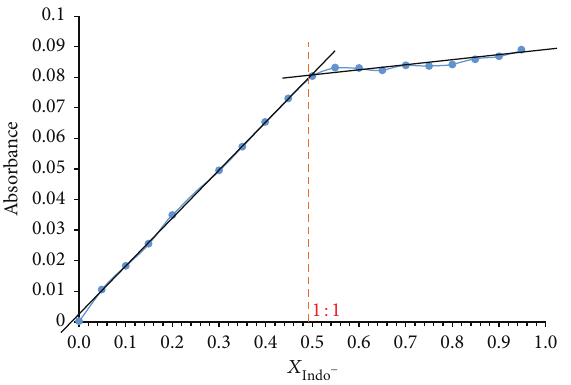
Figure 10: 𝐴 335 = 𝑓(𝑋 Indo − ) graph. In 𝑋 Indo − = 0.5 , the complex with stoichiometry 1: 1 (CuIndo + ) is formed.